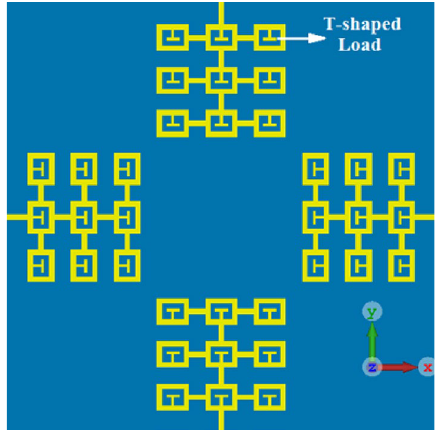
Figure 3. Reference antenna array loaded with T-shaped matching stubs. The standard ground plane remains